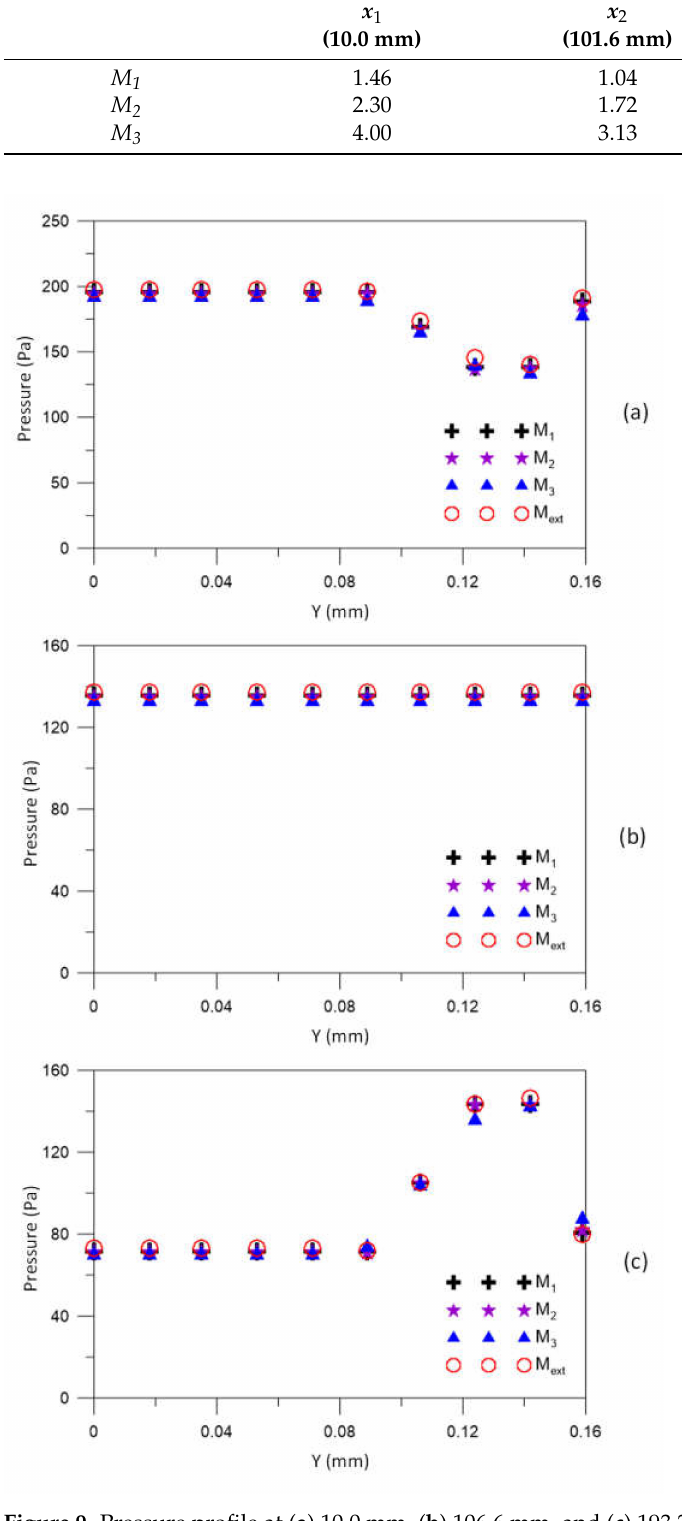
Figure 9. Pressure profile at ( a ) 10.0 mm, ( b ) 106.6 mm, and ( c ) 193.2 mm axial positions for differ- ent